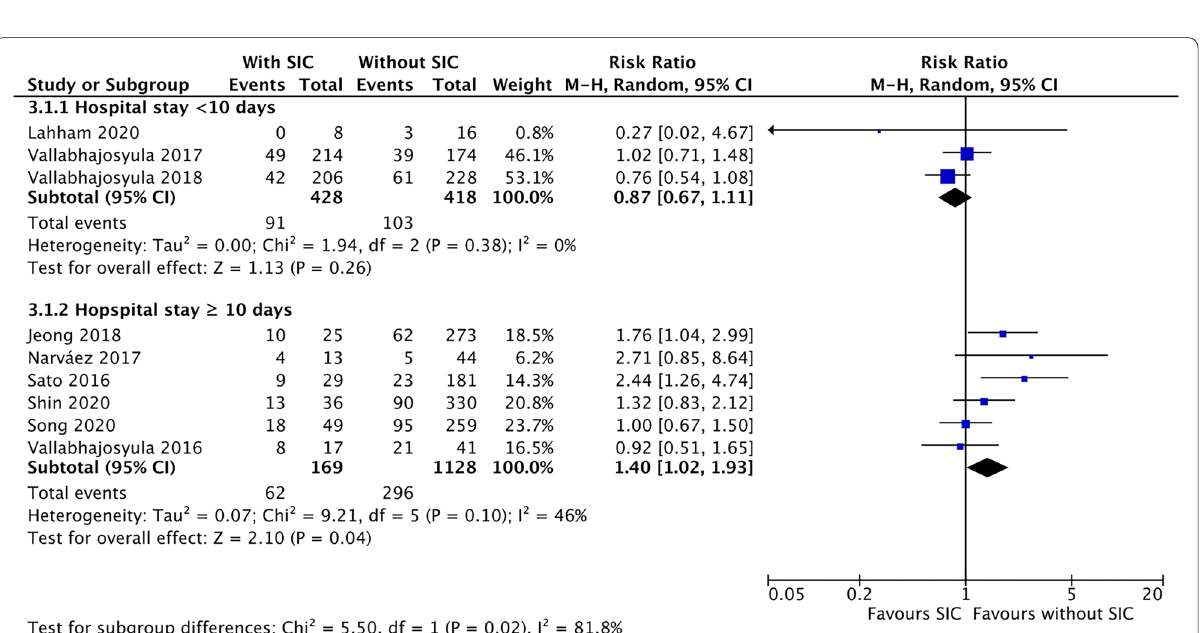
Fig. 4 The forest plot presents the result of a subgroup analysis dividing in‑hospital mortality into shorter (< 10 days, upper part) and longer ( 10 days, lower part) lengths of hospital stay. SIC is associated with a higher risk of in‑hospital mortality among septic patients with a length of ≥ hospital stay